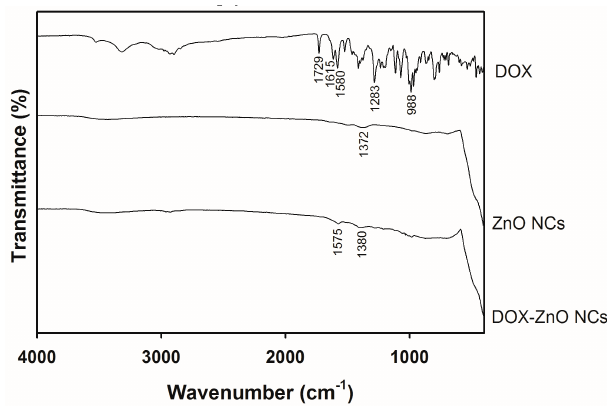
Figure 3. FT-IR spectra of DOX, ZnO NCs, and DOX-ZnO NCs. Transmittance according to the wavenumber of each sample is plotted.